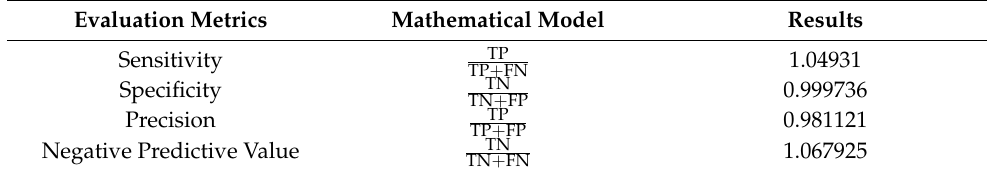
Table 8. The results of evaluation